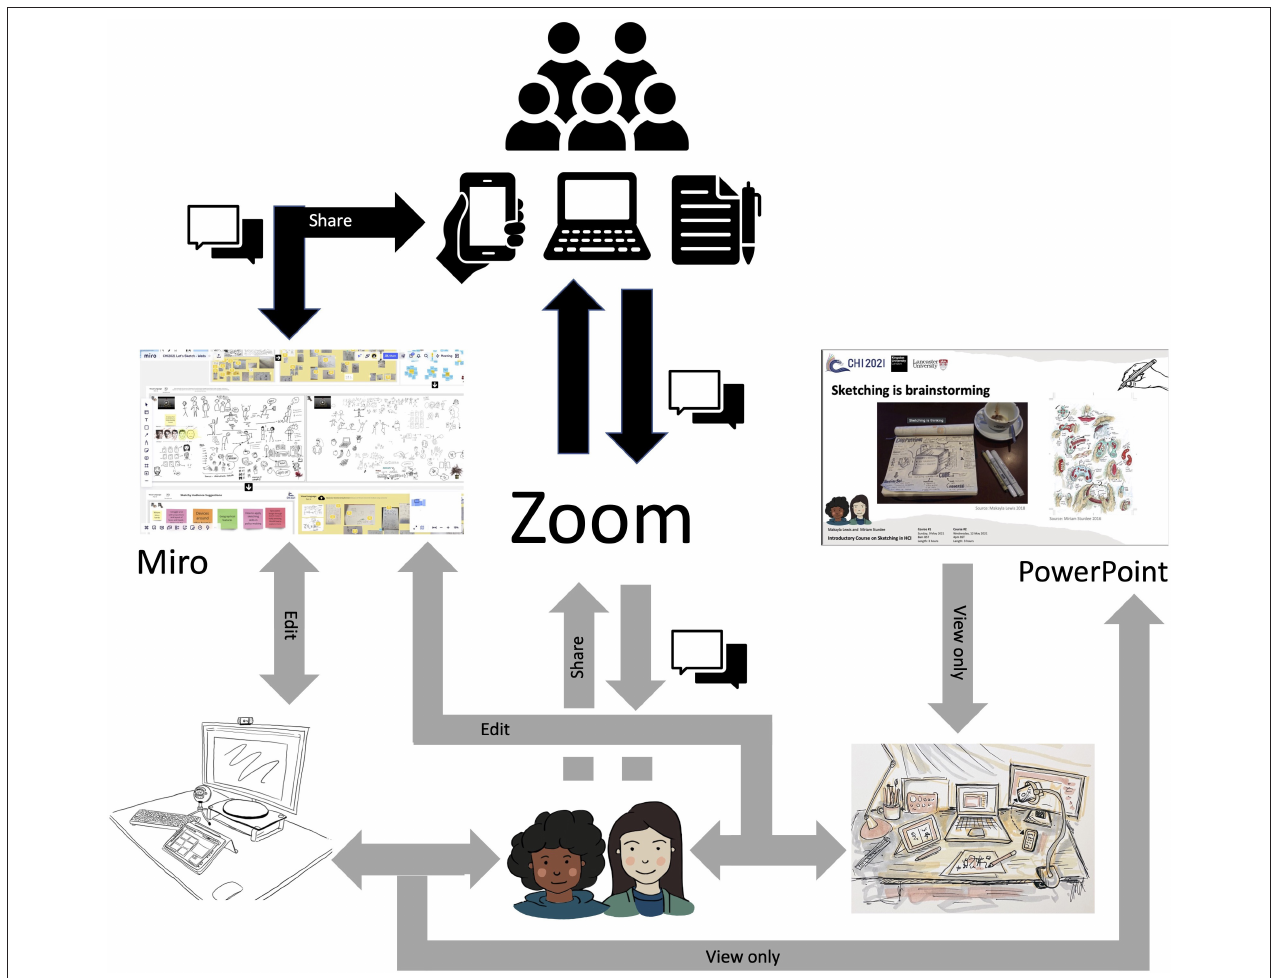
FIGURE 13 | ACM CHI 2021 delivery setup. Makayla Lewis and Miriam Sturdee,